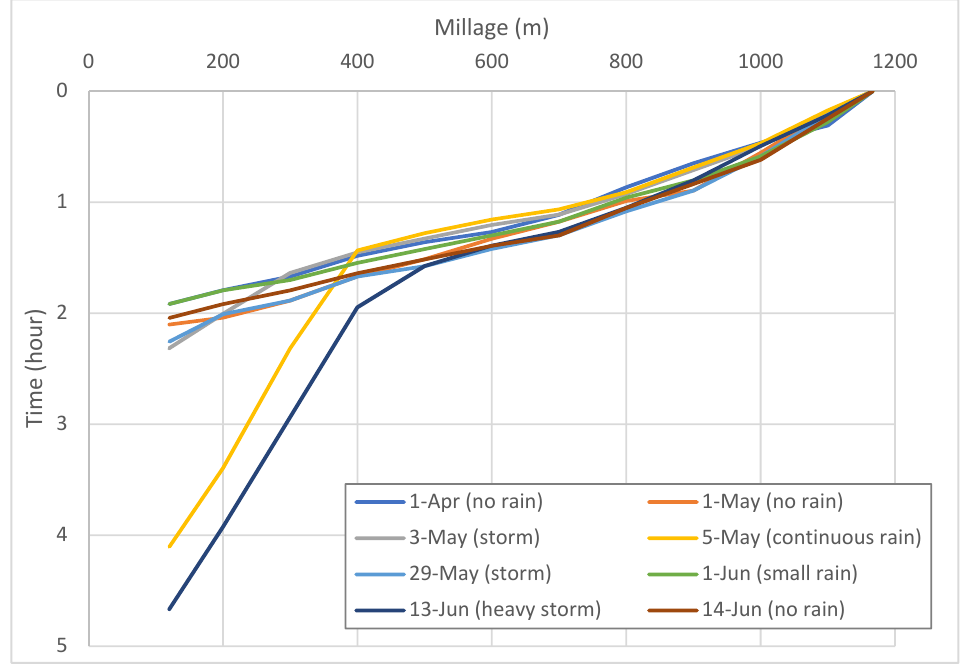
Figure 7. Tracking of the position of the front of warmer wastewater plumes transiting through the sewer.